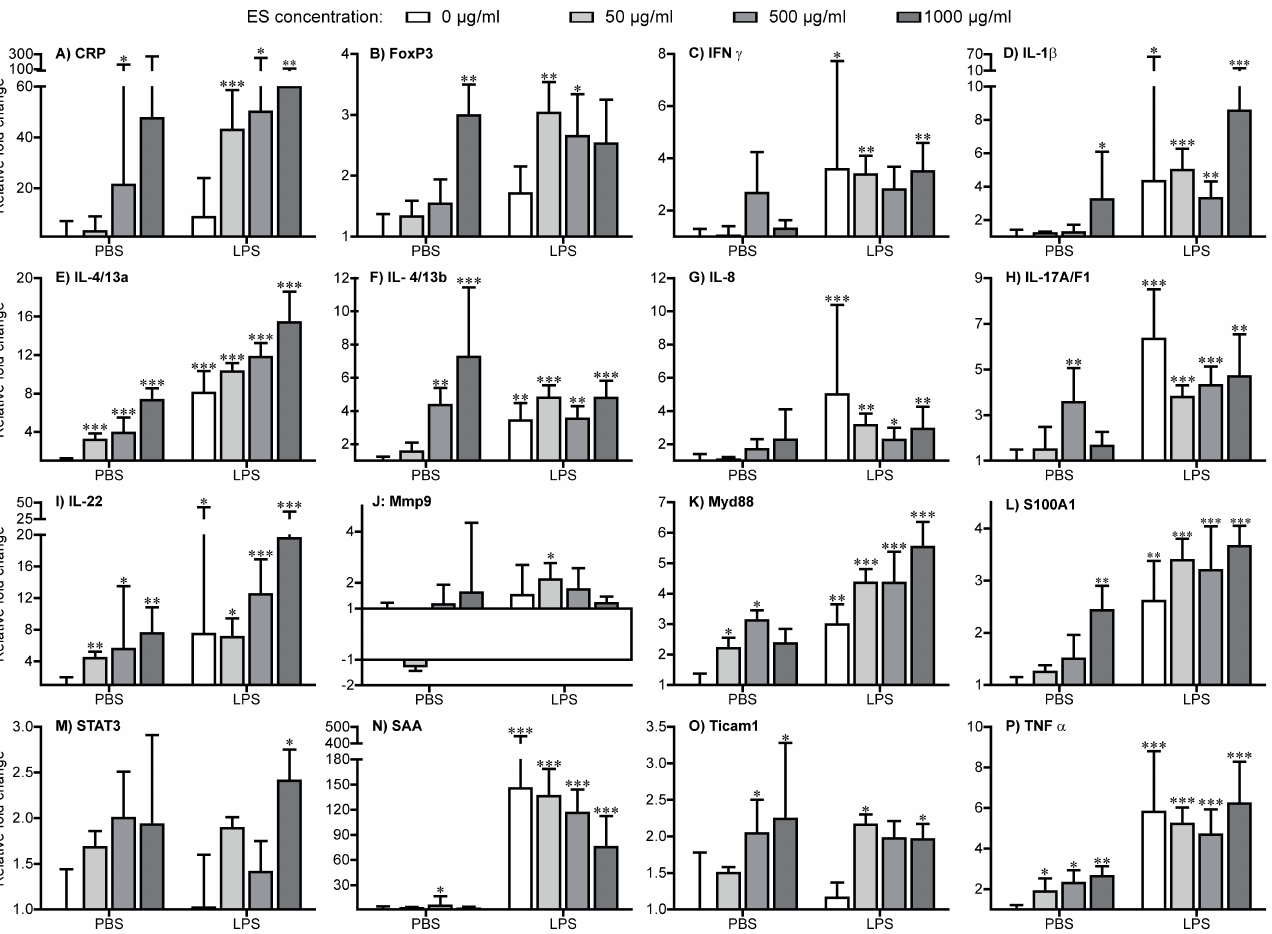
Fig 2. Expression of immune genes in zebrafish after exposure to PBS or LPS plus ES compounds. Fold change in all groups are compared to expressionin PBS-injected zebrafish. As the efficienciesof all the assays were within 100% ± 5%, the simplified2 – ΔΔ Cqmethod were used to calculatethe relative fold change.Asterisk sign: significancelevel of fold changesof each gene( * P < 0.05; ** P < 0.01; *** P < 0.001) and fold changesof at least 2. The elongationfactor 1 α ( EF-1 α )was used as the reference gene.